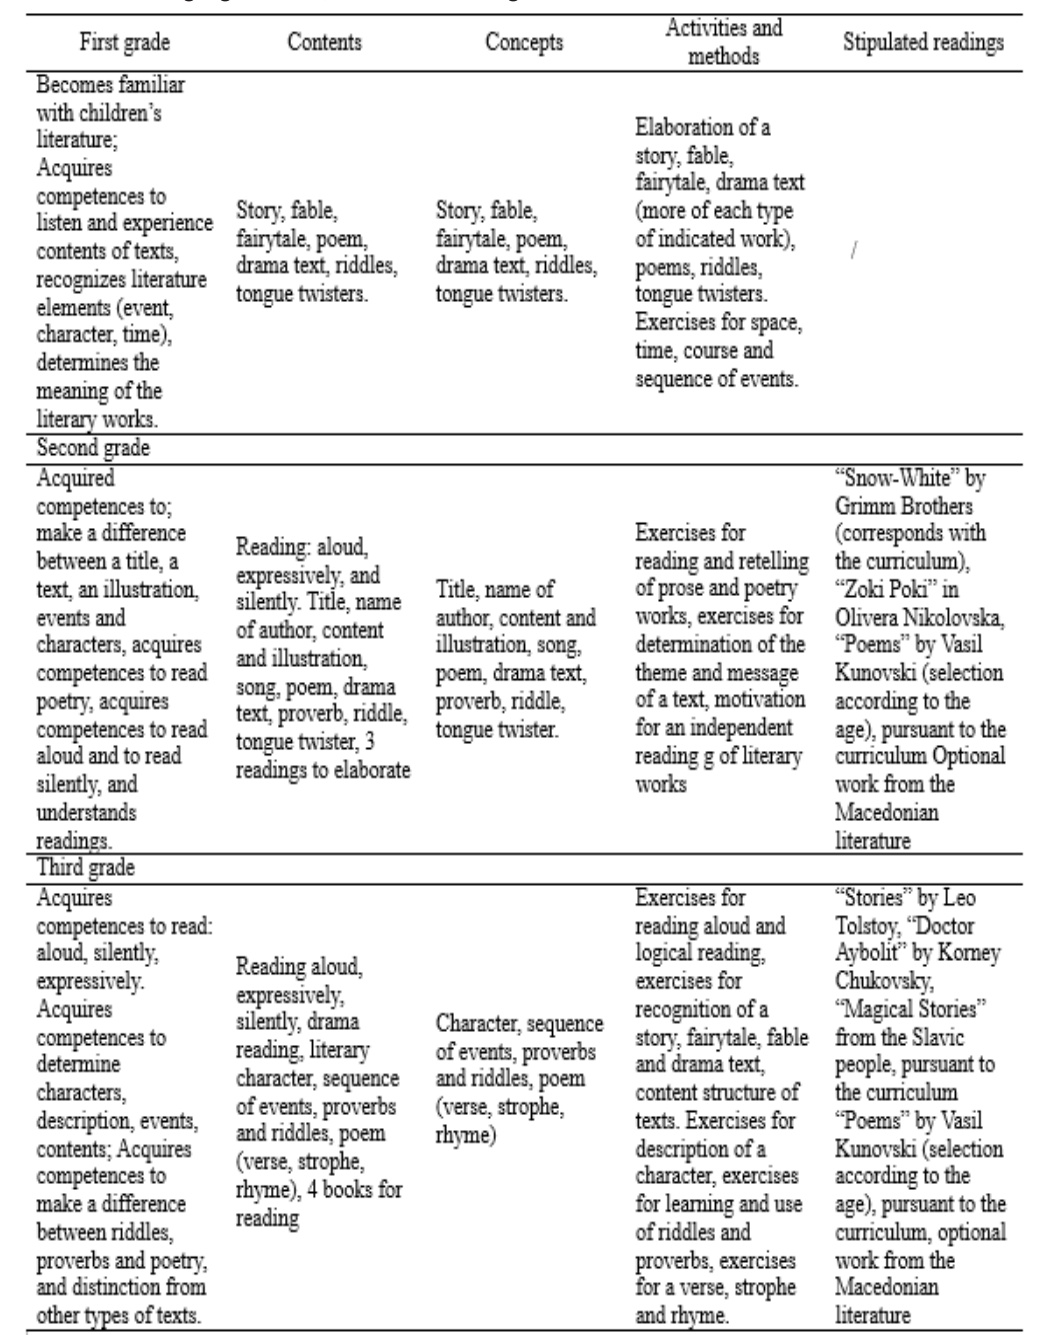
Table 1. Objectives, contents and activities stipulated with the Curriculum for the subject Macedonian language for first, second and third